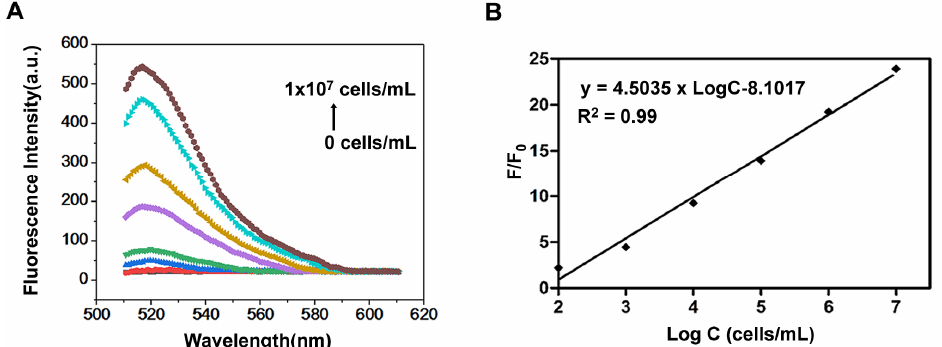
Figure 4. LoVo cells’ detection using a FAM-W3-GO fluorescent aptasensor. ( A ) The fluorescence spectra of FAM-W3-GO after incubation with different concentrations of LoVo cells from 0 to 1 × 10 7 cells/mL. ( B ) Calibration plot of the fluorescence intensity rate ( F/F 0 ) versus the concentration of LoVo cells. Table 1. Comparing the linear range and detection limit of different W3 aptamer-based aptasensors. Detection